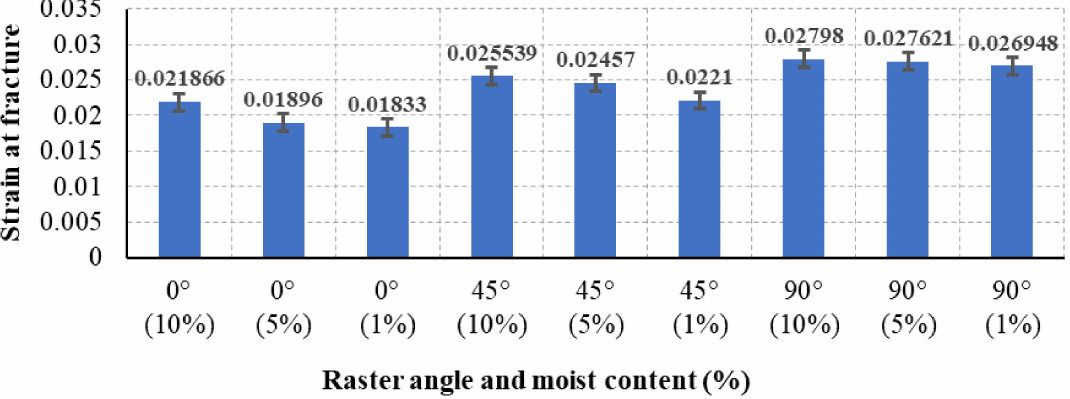
Figure 8. Strain at fracture in mm/mm for all specimens with different raster angles and moisture content.